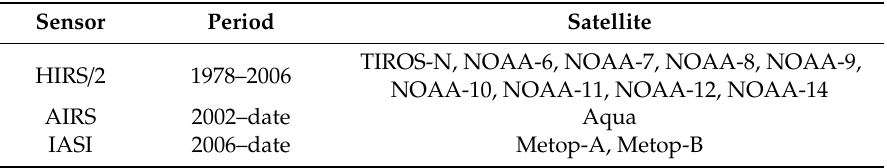
Table 3. Datasets of reference